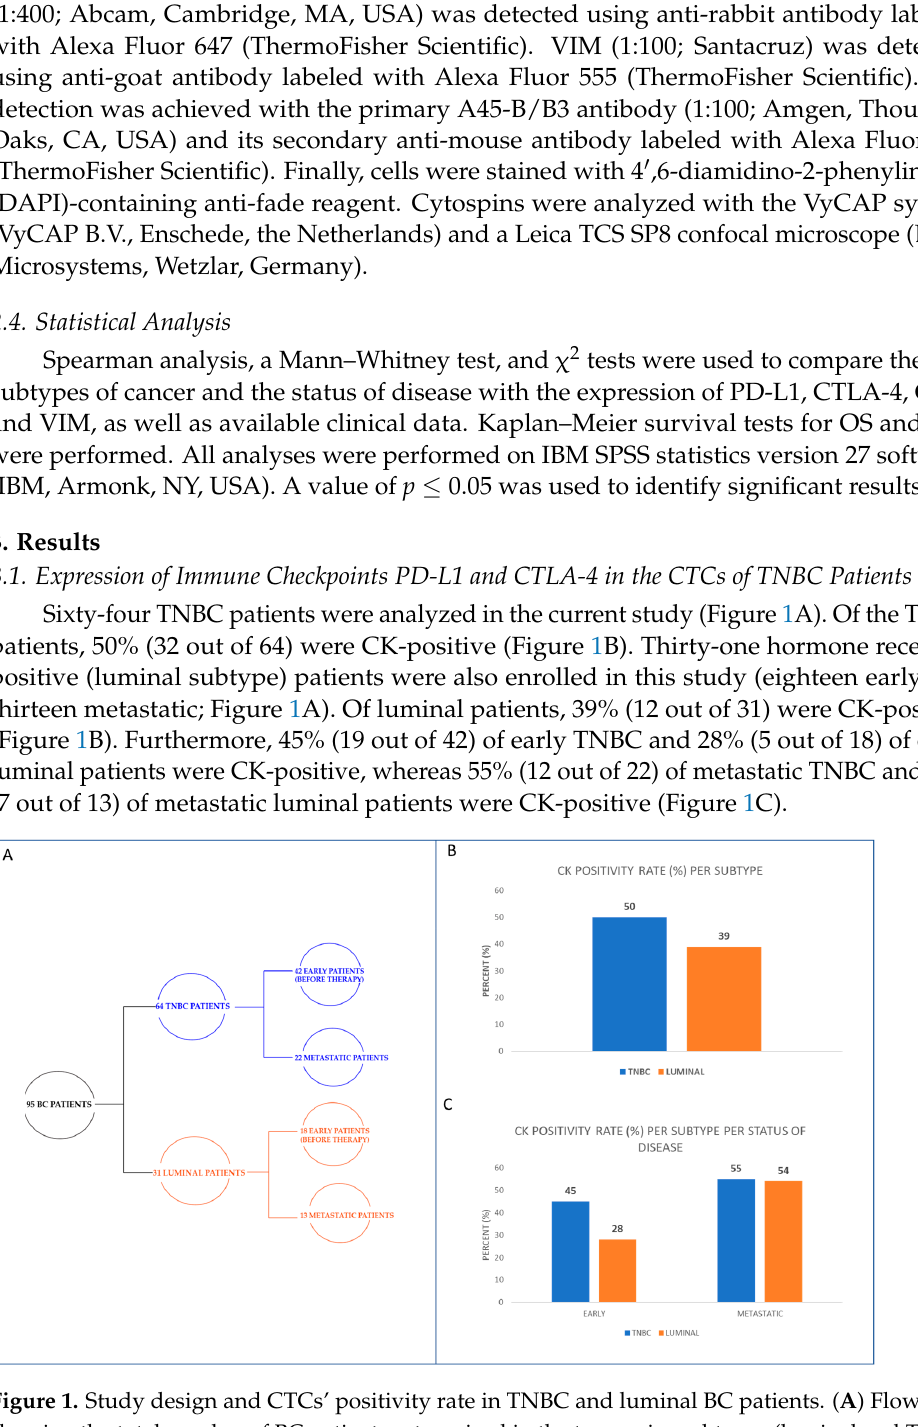
Figure 2. PD-L1 and CTLA-4 expression in TNBC patients’ CTCs. ( A ) Percentage of TNBC patients with all the different phenotypes. ( B ) Percentage of early and metastatic TNBC patients with the corresponding CTC phenotypes (* p = 0.025). ( C ) Percentage of CTCs with all the corresponding phenotypes in TNBC patients. ( D ) Percentage of CTCs with all the corresponding phenotypes in early and metastatic TNBC patients (** p = 0.049, *** p = 0.024). Considering disease status, the percentage of CTCs expressing the phenotype PD- L1 + CD45 − CK + in early vs. metastatic disease was 70% vs. 91%, respectively, whereas the percentage of PD-L1-negative CTCs was 30% vs. 9% ( p = 0.049), respectively. The same percentages for the CTLA-4 + CD45 − CK + phenotype were 61% vs. 80% ( p = 0.024), respec- tively, while for CTLA-4 − CD45 − CK + phenotype they were 39% vs. 20%, respectively (Fig- ure 2D, Table S1). Hence, frequency of the phenotype CTLA-4 + CD45 − CK + was higher in